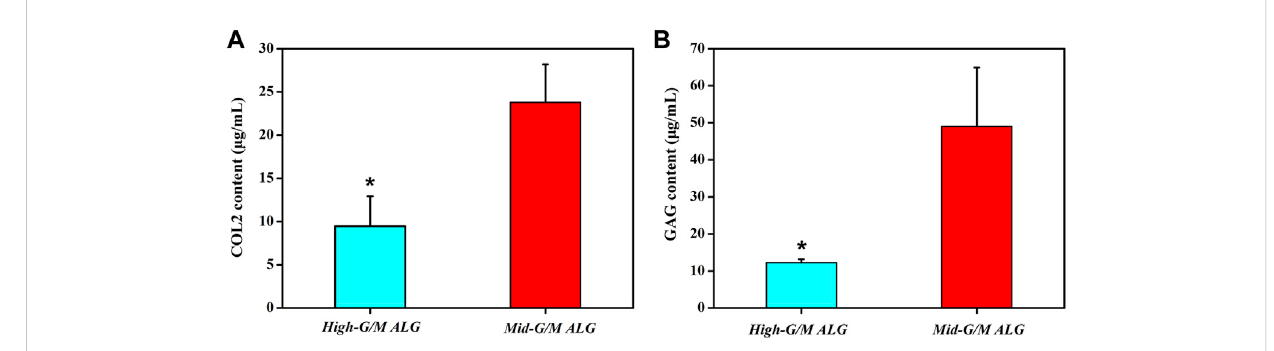
FIGURE 6 Quanti fi cation of (A) collagen type II (COL2) and (B) matrix production (GAG) of chondrocytes on High-G/M ALG/COL and Mid-G/M ALG/COL hydrogels evaluated via ELISA. Dates arerepresented asthemean± SD(n= 3).(* p < 0.05 indicatesasigni fi